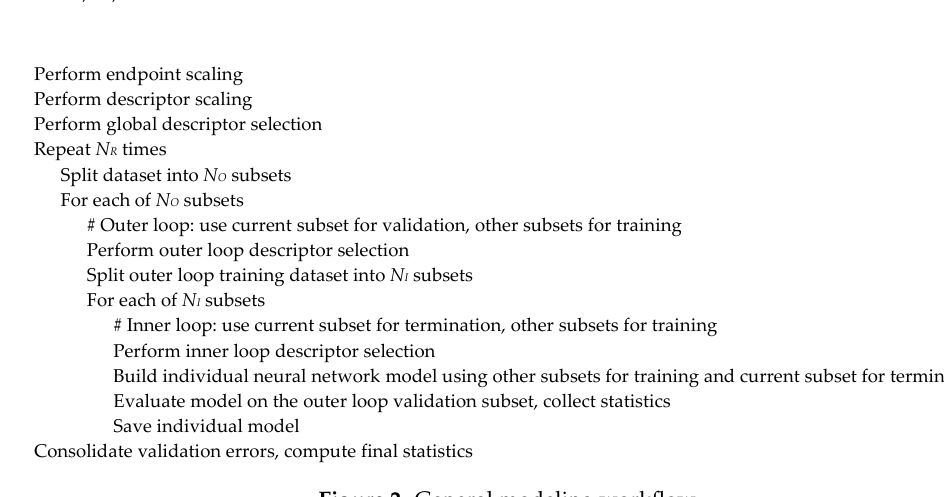
Figure 2. General modeling workflow.